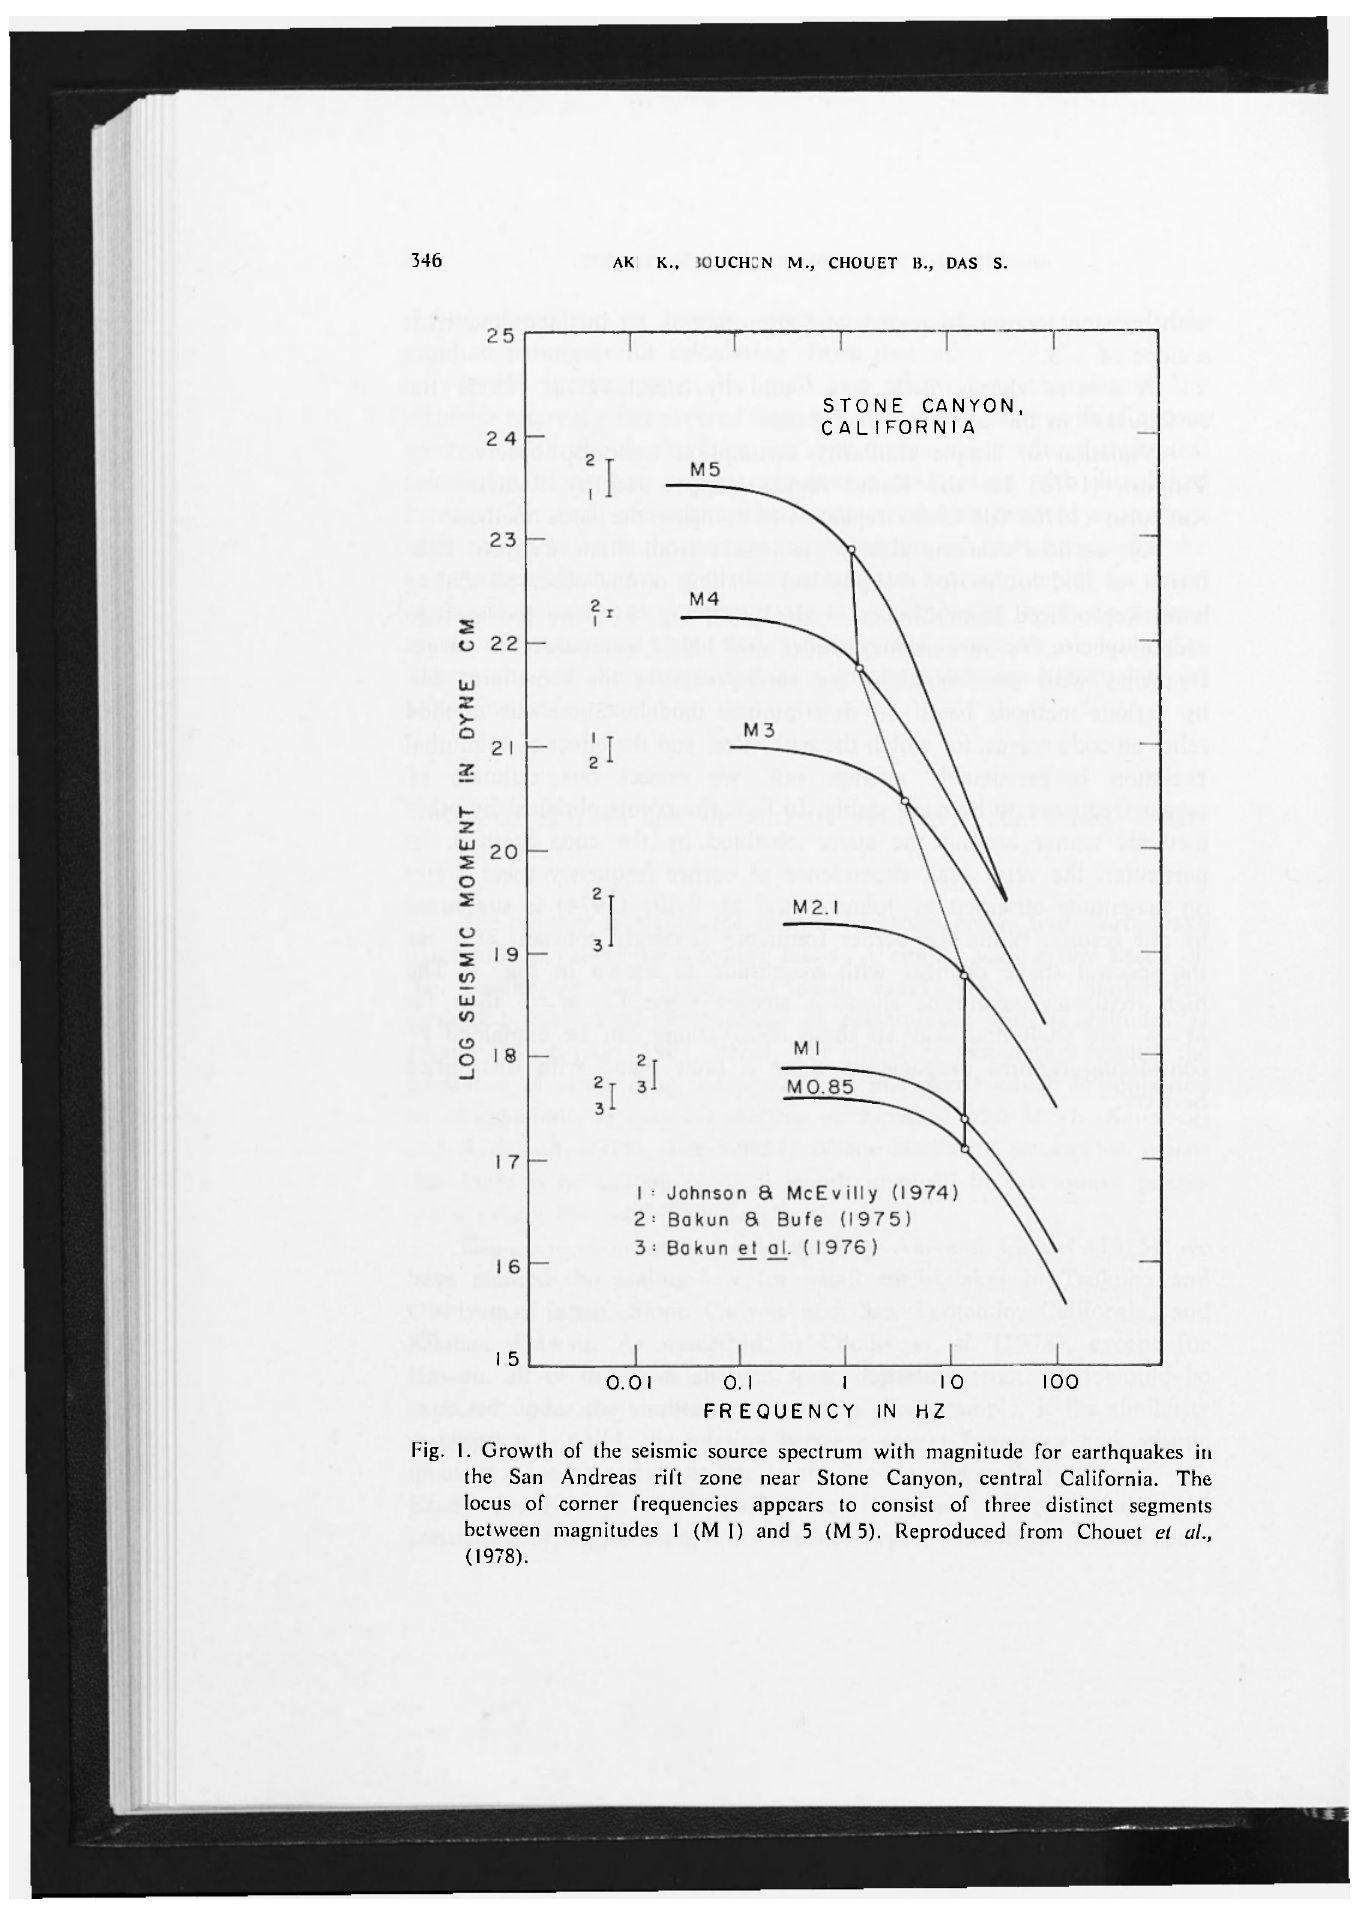
Fig. 1. Growth of the seismic source spectrum with magnitude for earthquakes in the San Andreas rift zone near Stone Canyon, central California. The locus of corner frequencies appears to consist of three distinct segments between magnitudes 1 (Ml) and 5 (M 5). Reproduced from Chouet et al.,